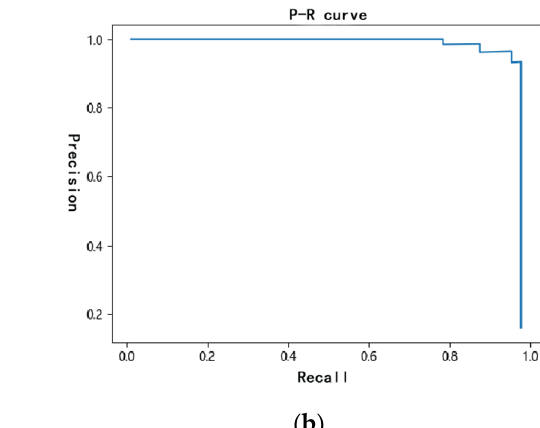
Table 9. Performance comparison of different object detection models.